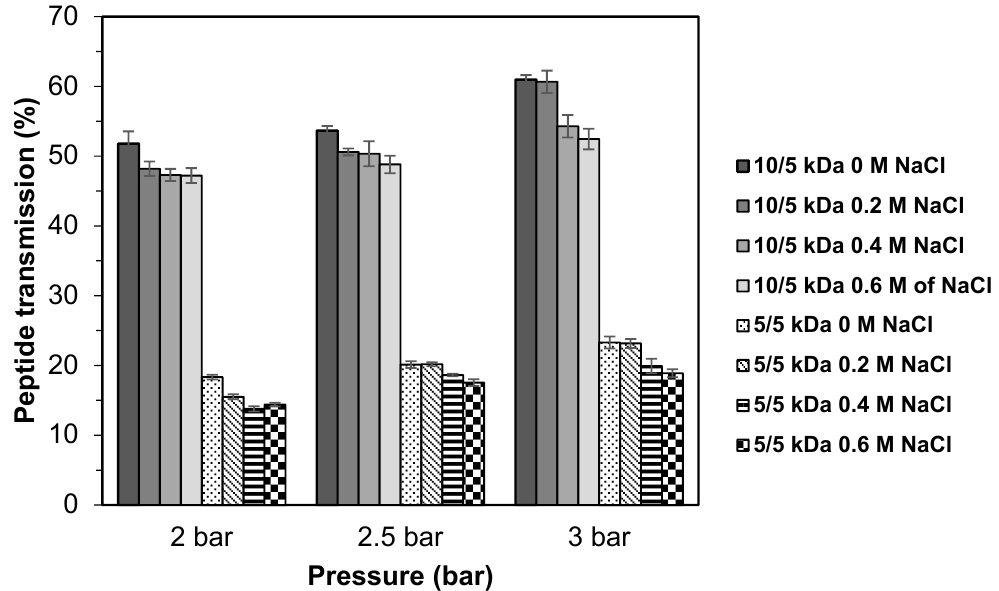
Figure 7. Peptide transmission of TB protein hydrolysate through multilayer UF membranes at different salt concentration (NaCl).